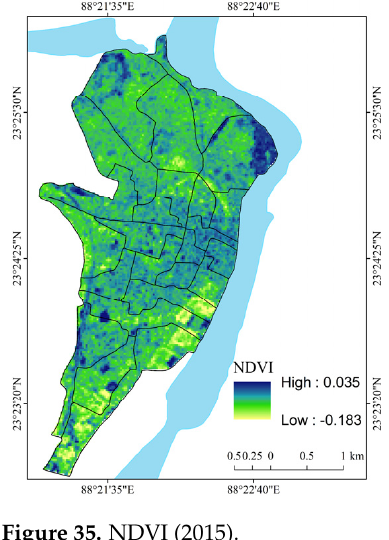
Figure 34. Flow length line density (2015).